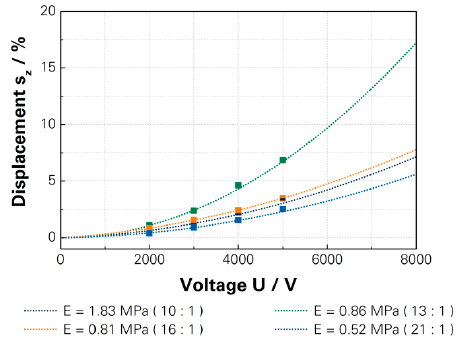
Figure 8. Measured actuation displacements and characteristic curves of full polymer DEA with